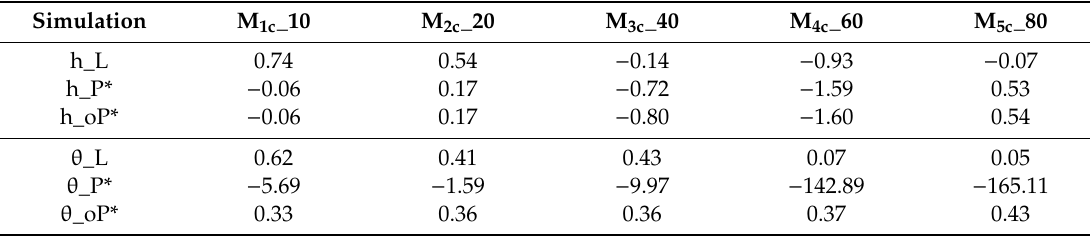
Table 5. E ffi ciency coe ffi cients calculated for matric head and water content data at each depth instrumented in Lys. 1 using HYDRUS-1D.